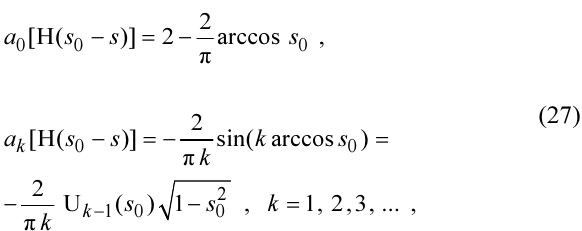
Fig. 5. Form of moving load